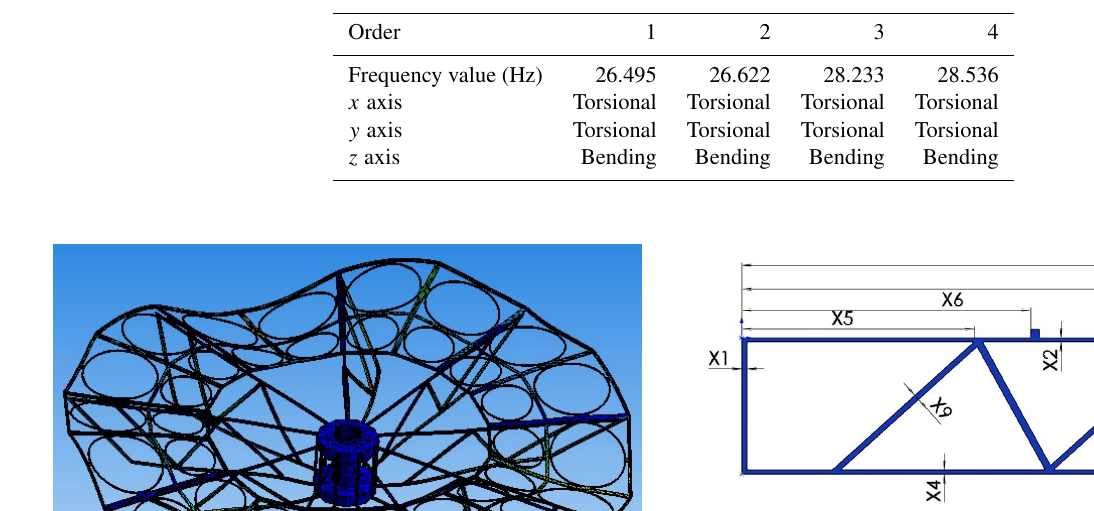
Table 3. Natural frequencies of the first- to fourth-order free modes of the thin-film diffraction imaging system.